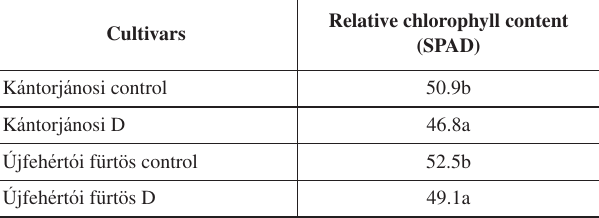
In each column, means followed by the same letter are not significantly different